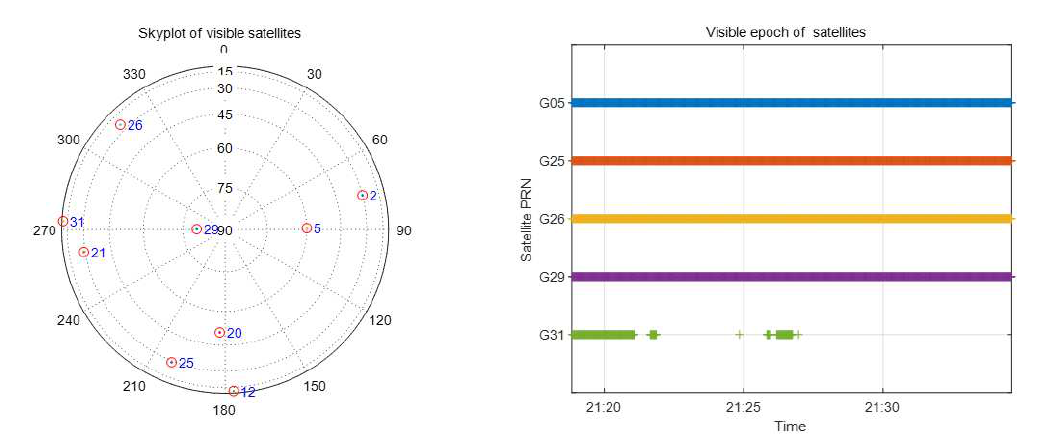
Figure 3. Skyplot and epoch of visible satellites 21:19–21:34, 16 August 2017. Five IGS stations (http://www.igs.org/networkWILL, SASK, PRDS, DRAO, BREW) around Calgary are selected to estimate the multi-station satellite DCBs, and these stations are shown in Figure 4. The RINEX files (ftp://cddis.gsfc.nasa.gov/pub/gps/data/daily/), the IONEX data (ftp://cddis.nasa.gov/pub/gps/products/ionex/), and the MGEX clock product Standard Product 3 (SP3) files (ftp://cddis.gsfc.nasa.gov/pub/gps/products/ week/) are used in our experiment.